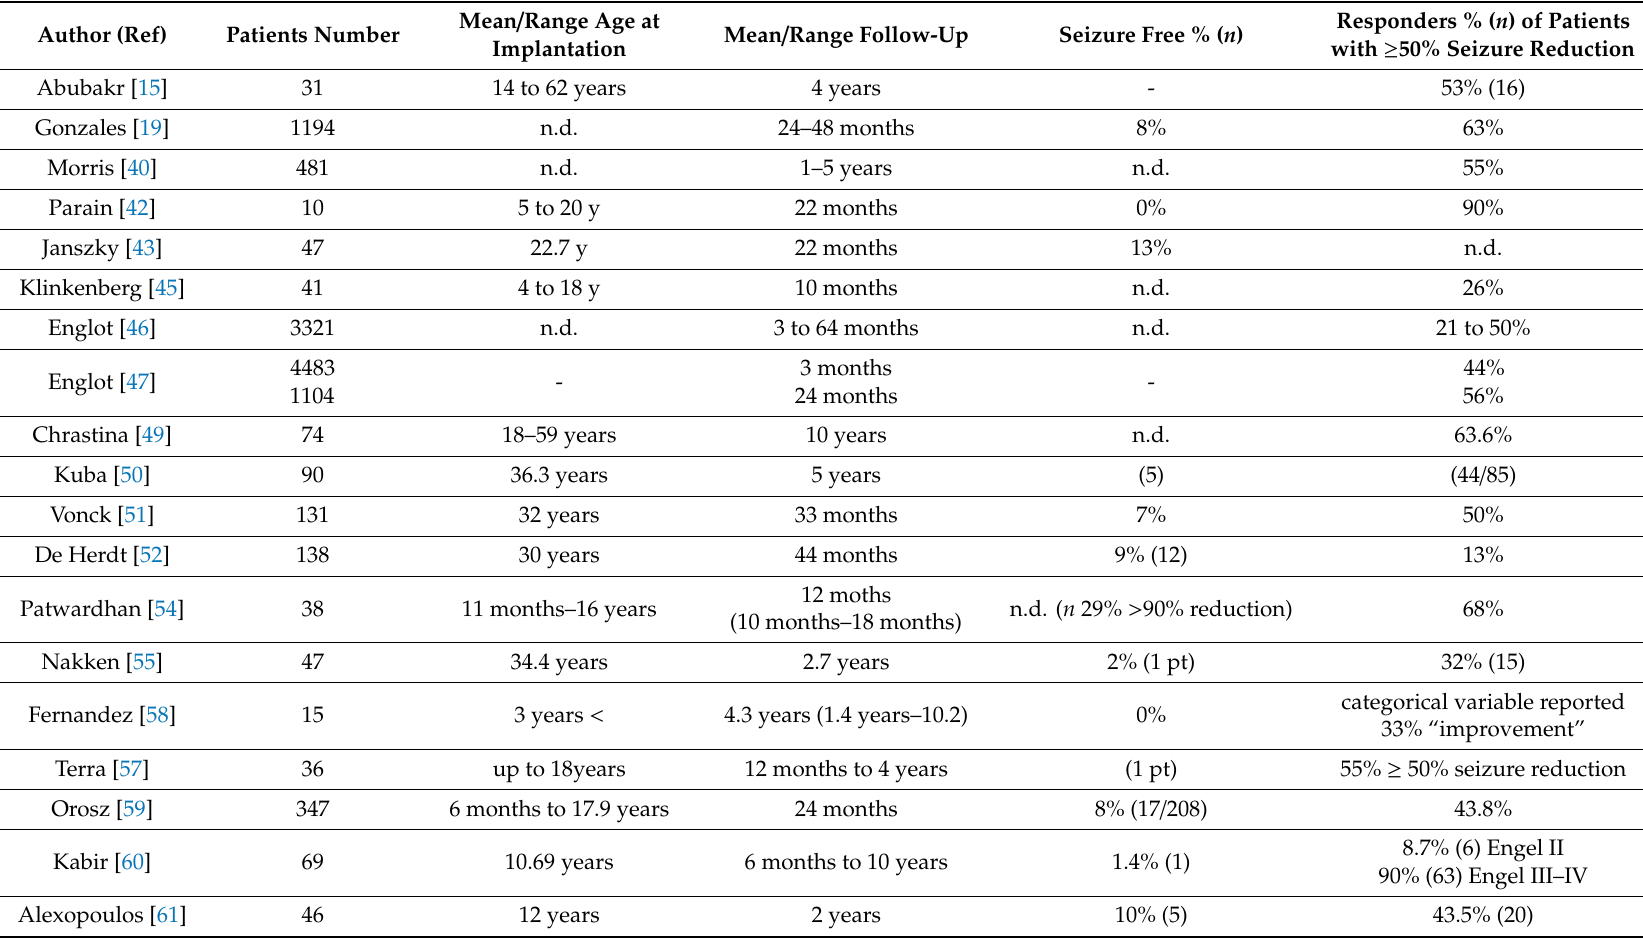
Table 1. VNS series including a minimum 10 patients with a follow-up higher than 6